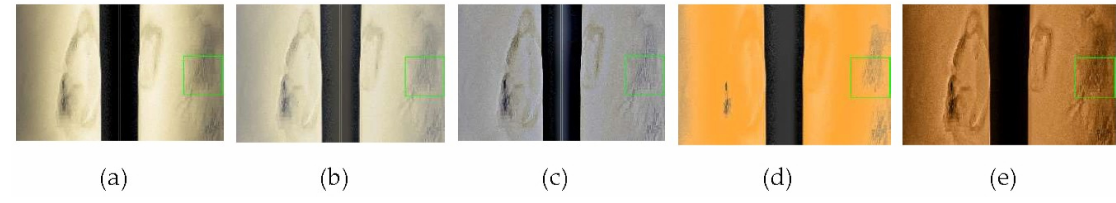
Figure 9. Comparative experiment of common methods based on Retinex. Images enhanced with ( a )